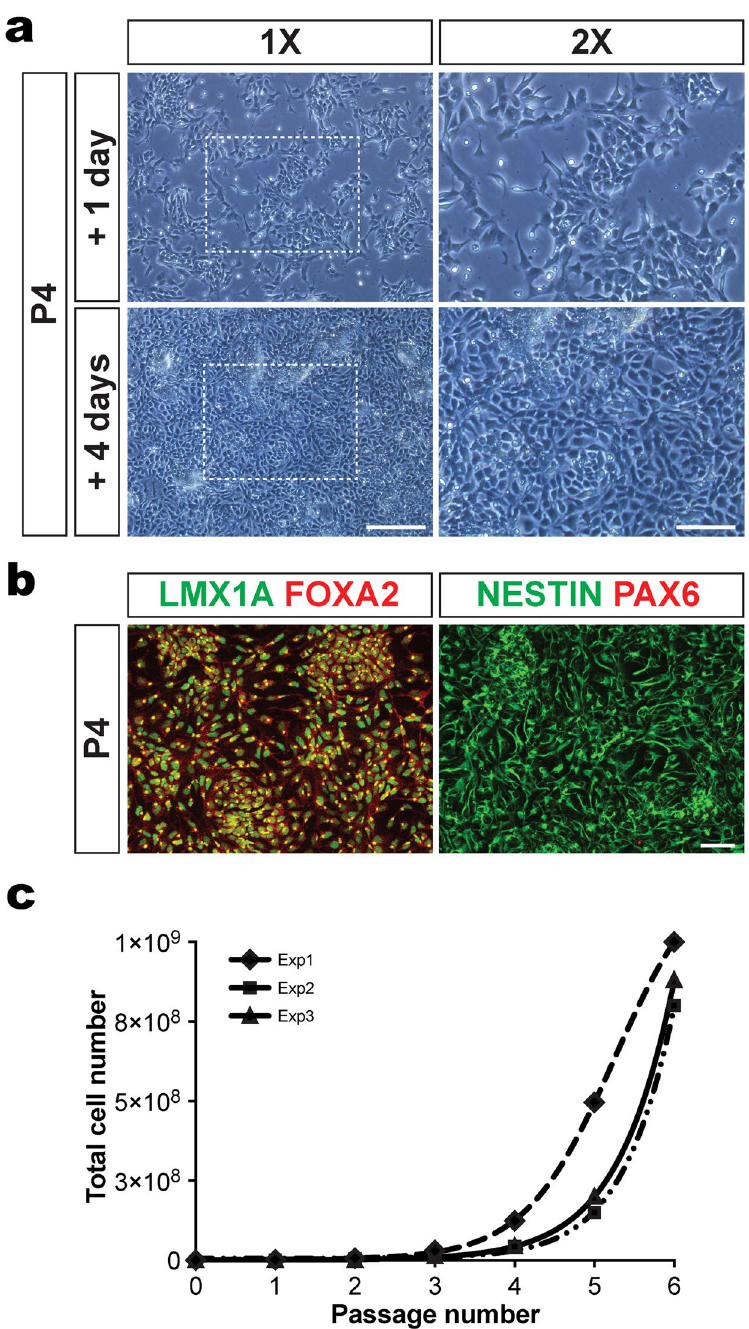
Figure 2. Characterization of hiPSC-derived expanded mFPPs. ( a ) Typical morphology of hiPSC-derived expanded mFPPs at passage 4 (P4) one and four days after passaging. Progenitors proliferated and reached 100% confluency within 3–4 days at each passage. ( b ) Immunocytochemical analysis of expanded mFPPs at passage 4 (P4) showed the expression for LMX1A, FOXA2 and NESTIN. No PAX6 + cells were observed during the expansion, demonstrating the maintenance of midbrain floor plate phenotype. ( c ) Representation of total number of mFPPs generated after 6 passages (P1–P6) in three independent experiments. At the end of the expansion (P6), 8.9 × 10 8 ± 1 × 10 8 progenitors were produced in total. Scale bars: 200 μ m and 100 μ m in a and 50 μ m in b